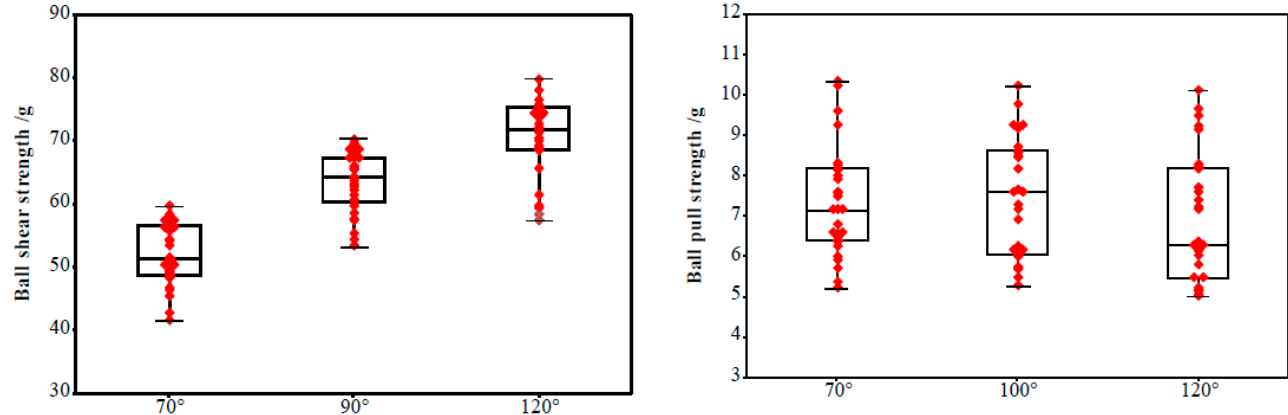
Figure 11. The shear strength and pull strength statistics of the ball bonded points with the different ICBA. With the increase of the ICBA of the capillary, the MBD size, the contact area between the ball bonded point and the pad, the shear strength of the ball bonded point all increase, and the ball bonded point has good reliability. However, in the case of the ICBA being greater than 120°, the MBD of the ball bonded point will be too close to the adjacent ball bonded points, which results in a short circuit of the bonded point, as shown in Fig- ure 10c. When the ICBA decreases, the height of the ball bonded point increases and the probability of false welding increases because the FAB volume remains unchanged and the MBD of the ball bonded point decreases. In addition, the height of the ball bonded point increases, the neck deformation rate of the ball joint becomes larger, and the stress concentration is more obvious, which reduces the reliability of the ball bonded point; When the ICBA is less than 70°, the control degree of the tip of the capillary on the FAB position is reduced, and the eccentric ball is easy to form in the bonding process, the bonding strength is reduced, and the short circuit probability of the ball bonded point is increased, as shown in Figure 10d. 3.4. Research on the Influence of TD on Bonded Point Morphology Figure 12 shows the morphology of the second bonded points with the different TD. When the TD is 178 μ m, the second bonded point is in the shape of a symmetrical fish tail and distributed with a small power ring mark; when the TD is 127 μ m, the second bonded point is similar to a fish tail shape, but has less extension on both sides and no power ring mark; when the TD is 241 μ m, the second bonded points are regular, the fish tail shape is symmetrically distributed, and the power ring mark is complete.